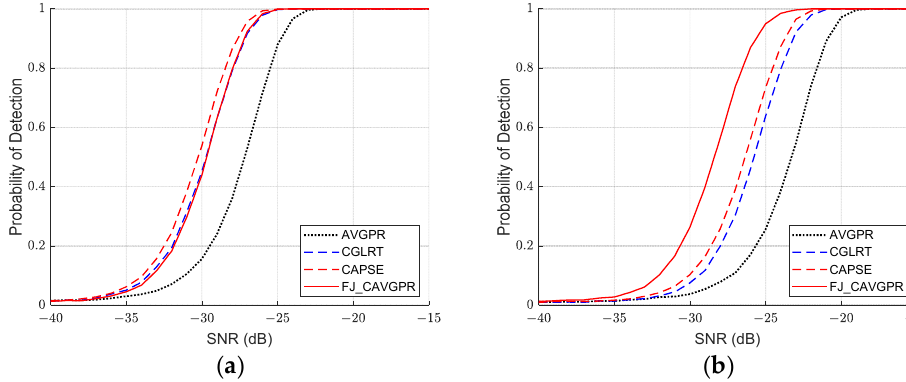
Figure 4. Detection performance of the four detectors at 𝑃 (cid:3007)(cid:3002) = 10 (cid:2879)(cid:2870) : ( a ) |∆| = 0 ; ( b ) |∆| = 0.5 .